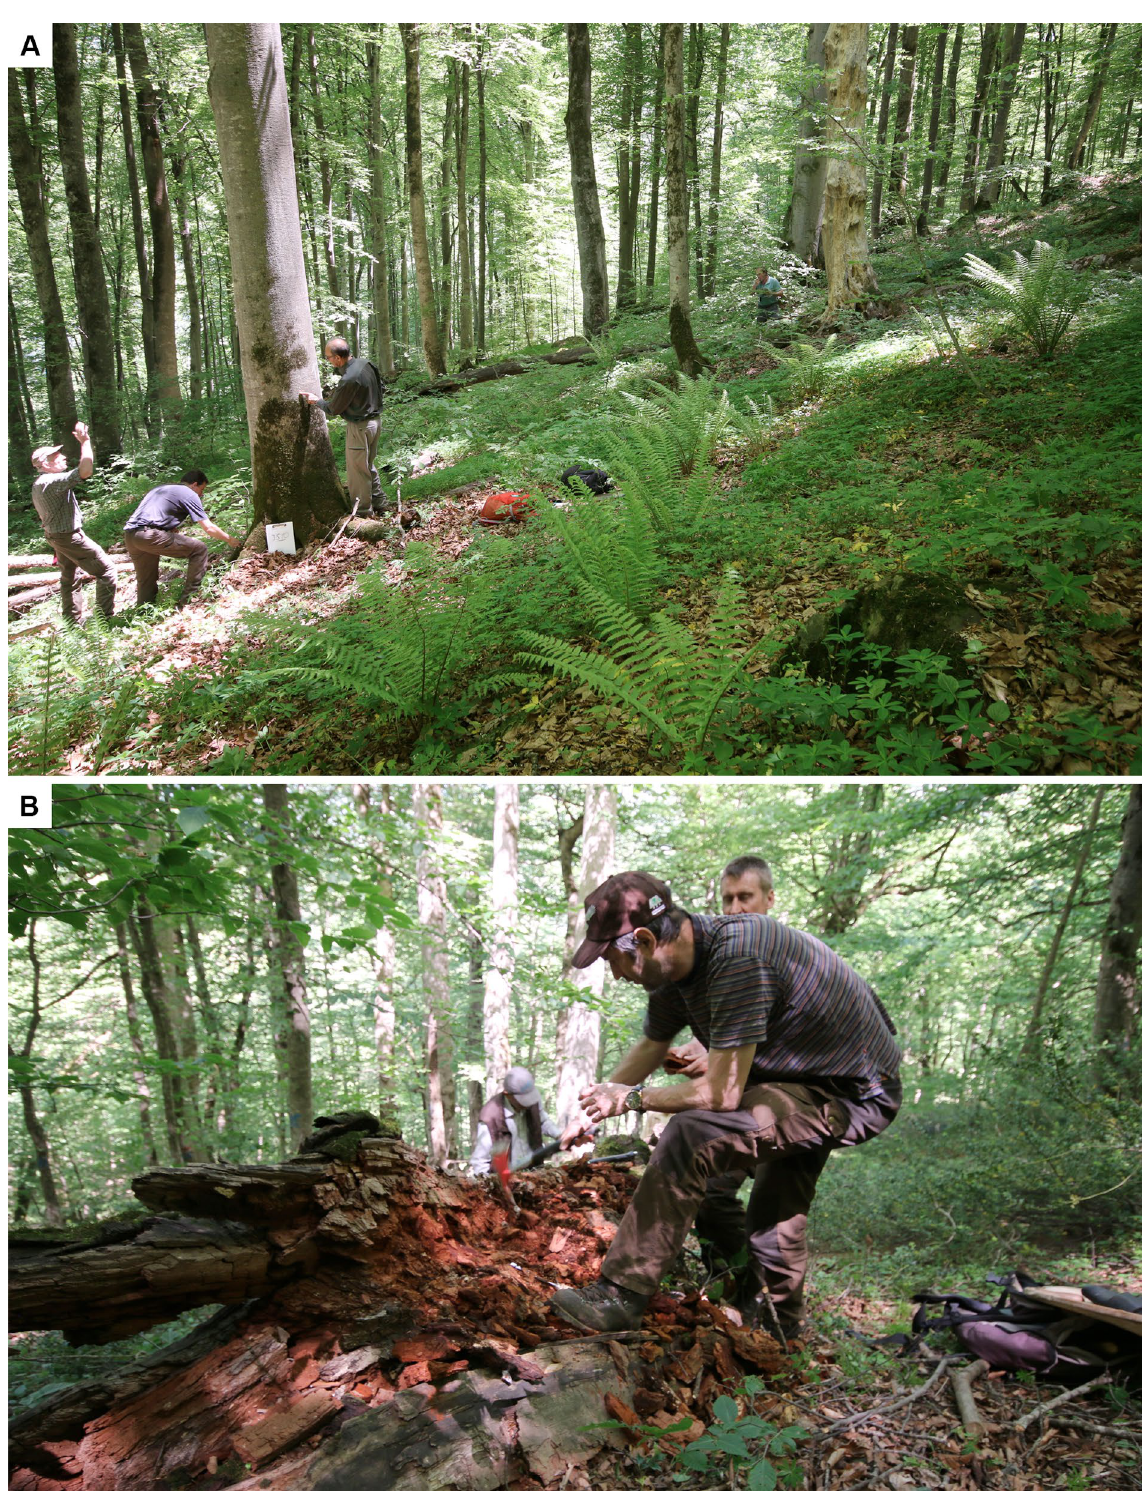
Fig. 5. habitat of Lacon mertliki sp. nov. in Iran, mazandaran province. A . Old-growth forest. B . Advanced brown rotten